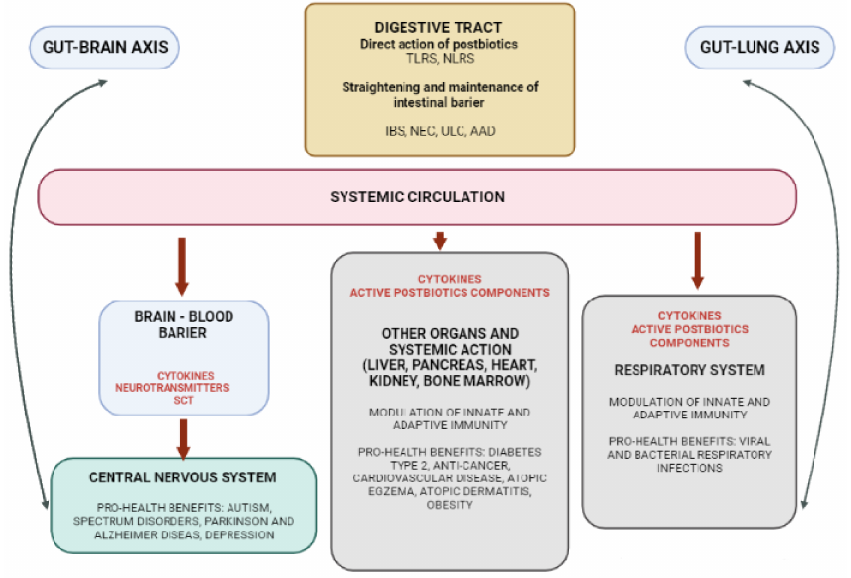
Figure 2. Postbiotics’ mechanism of action. Abbreviations: SCF—Short chain fatty acids;